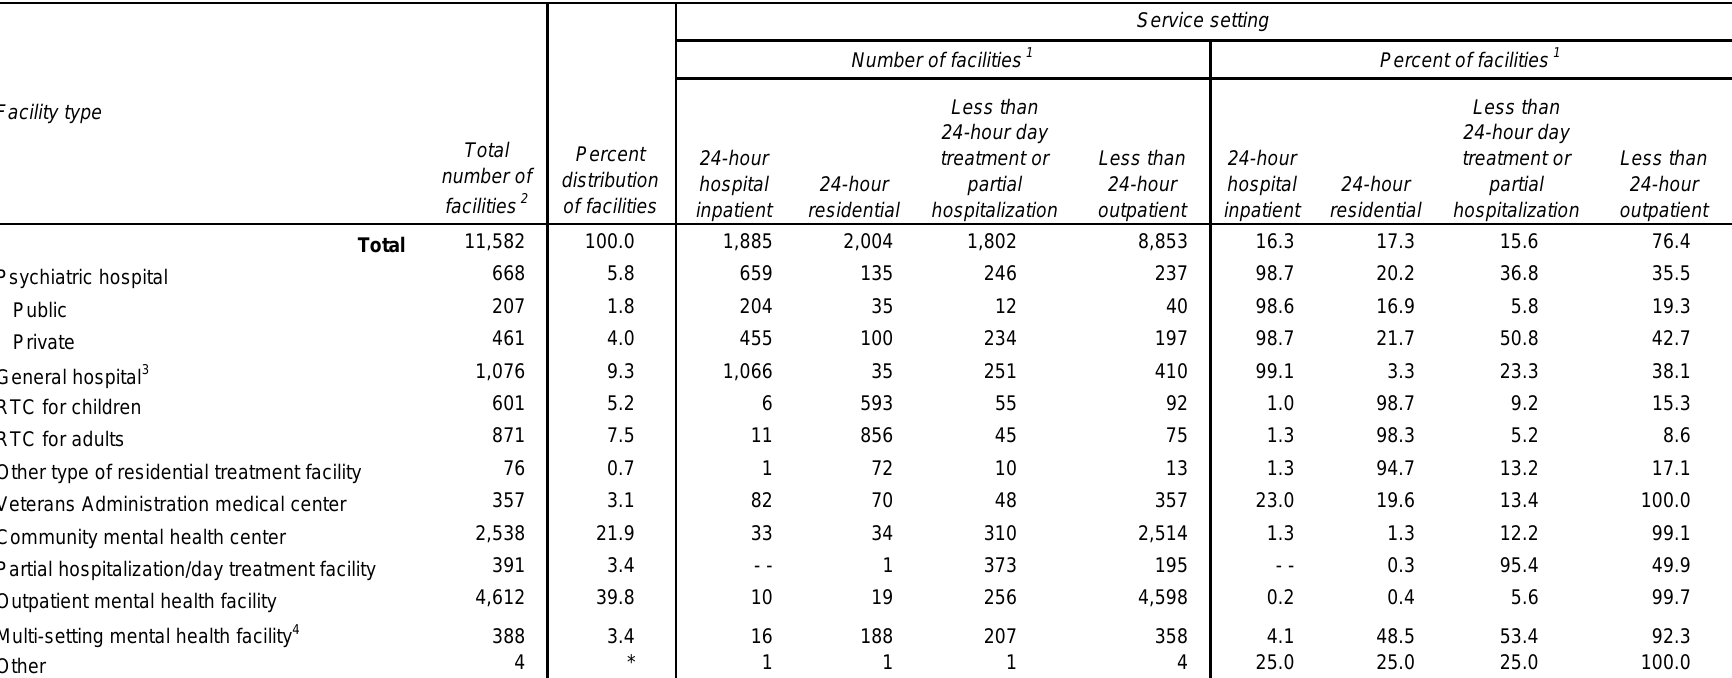
Table 2.1. Mental health treatment facilities, by service setting and facility type: Number and percent,